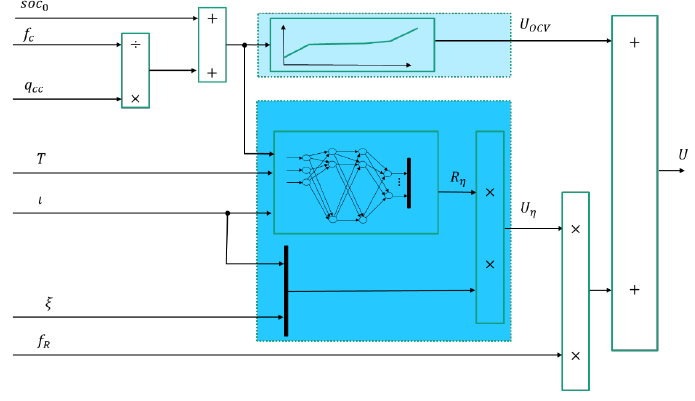
Figure 6. Structure of the core battery neural network.